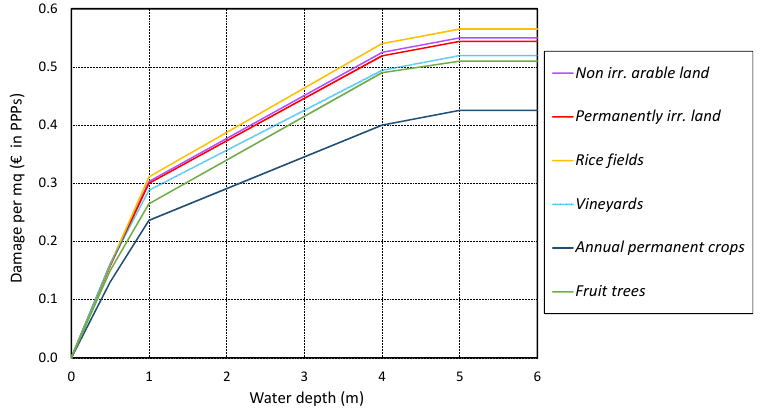
Figure 5. Depth–damage functions of main agricultural landcover classes for Italy (after [43]).